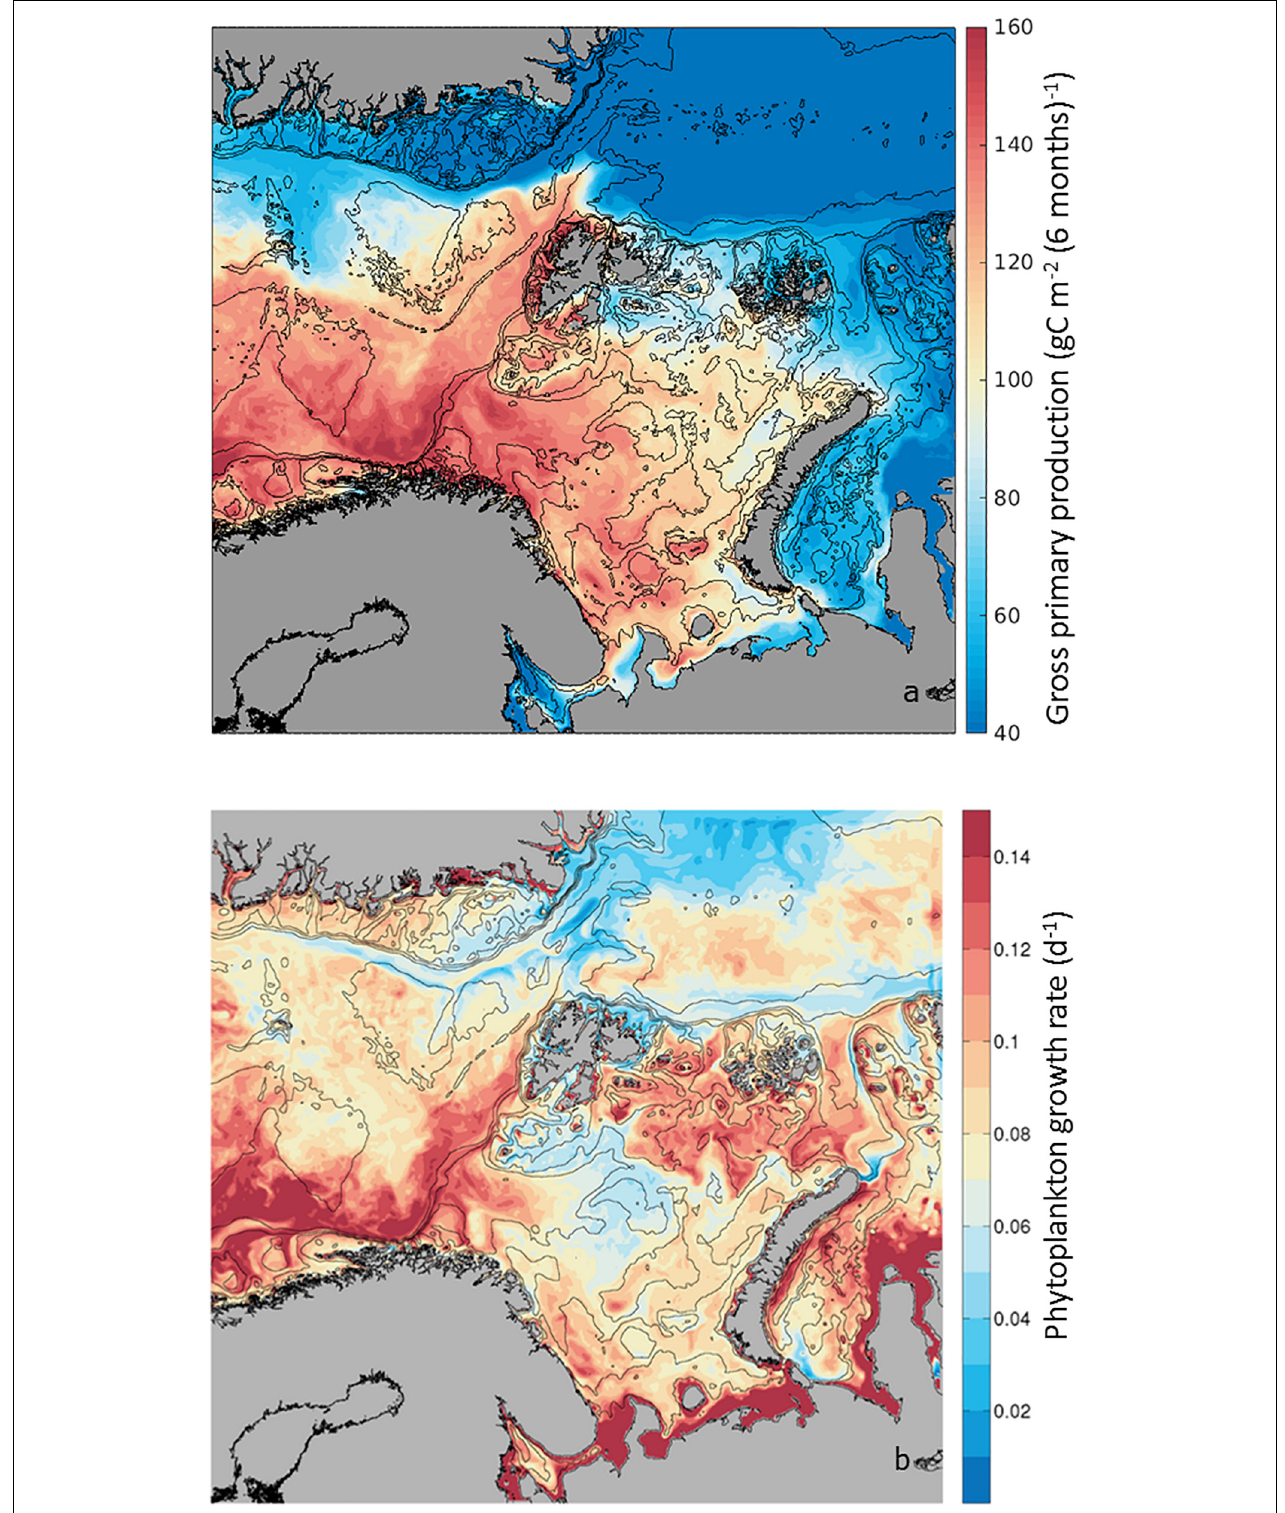
FIGURE 3 | (a) Seasonal phytoplankton Gross Primary Production (GPP) estimated as g C m − 2 6mo − 1 from April to September 2012. Low production (in blue) and high production (in red), from 20 to 200 g C m − 2 6mo − 1 ) for the study area. (b) Phytoplankton growth rate (d − 1 ) calculated in the SINMOD model as Net Primary Production/Biomass. Range of values from 0.02 d − 1 to 0.14 d − 1 . Note that in the literature (GPP-Respiration) is also considered phytoplankton primary production, also known as Net PP or NPP (e.g., Matrai et al., 2011).